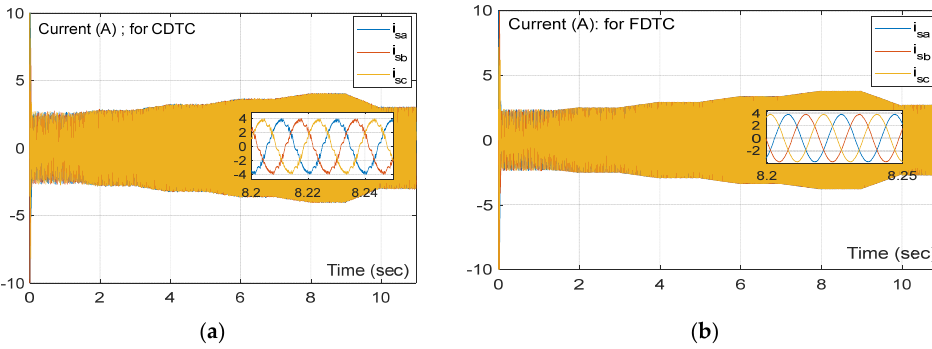
Table 5. Efficiency obtained for VSS-P&O MPPT technique under different operating conditions. Figure 14. Three-phase stator current for: ( a ) CDTC and ( b ) FDTC. Figure 14. Three-phase stator current for: ( a ) CDTC and ( b ) FDTC.